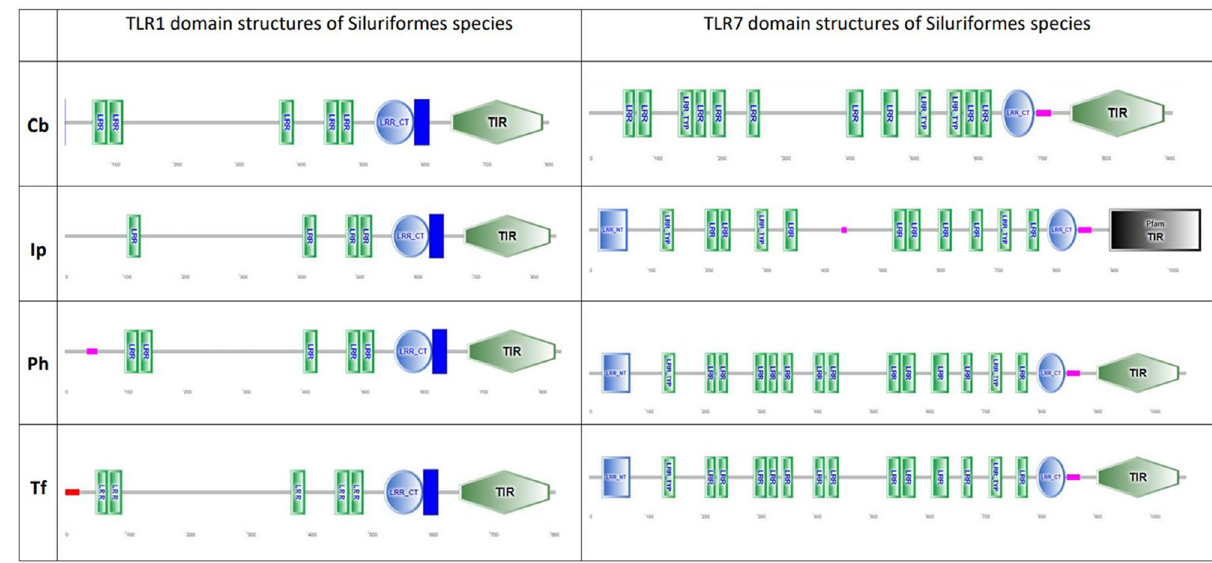
Figure 4. Comparative domain analysis of TLR1 and 7 of Siluriformes species ( Clarias batrachus (Cb), Ictalurus punctatus (Ip), Tachysurus fulvidraco (Tf), Pangasianodon hypophthalmus (Ph)) . (Domains predicted using SMART). The four domains detected in this analysis are ( a ) LRR—Leucine-rich repeats ( b ) LRR-CT—LRR-C- terminal ( c ) LRR-N-terminal and ( d ) TIR—Toll/interleukin-1 receptor. The comparative analysis shows a high degree of similarity in the organization of TLR1 and 7 domains of C. batrachus and its Siluriformes relatives.